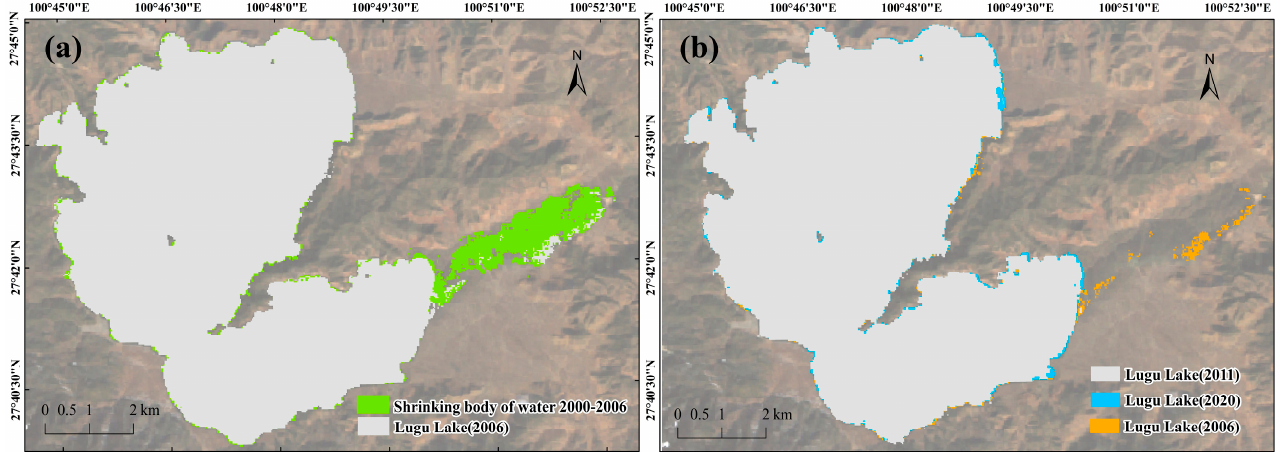
Figure 5. Lake area. ( a ) Trends in the average annual area of the six lakes; ( b ) Annual average change in area of the Lugu Lake from drought to wet season; ( c ) Annual average change in area of the Shengzhong Reservoir from drought to wet season.